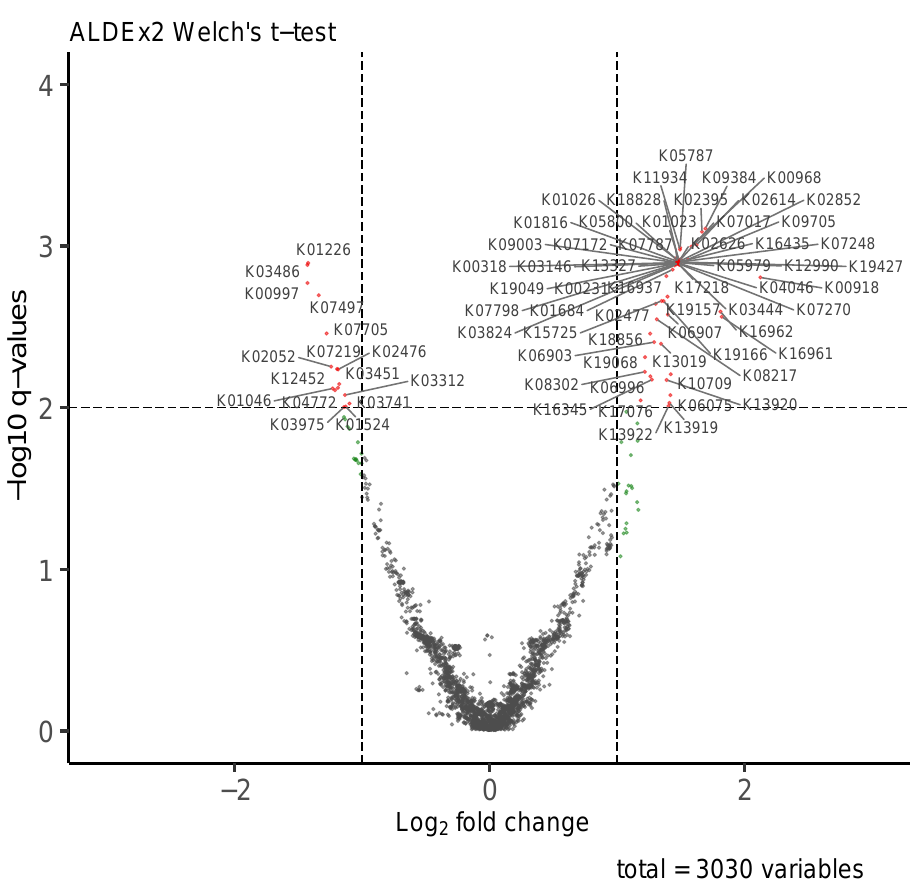
Figure 5. Volcano plot illustrating differentially involved KEGG terms based on the differentially abundant bacterial taxa between HFD-fed B6-mt ALR and B6-mt BPL mice. Each ID denotes respective KEGG ID. Pathways with the absolute log 2 fold change greater than 1 are considered to have suffi- ciently large positive and negative effect, respectively, and those with an adjusted p-values of minus log 10 q -value greater than 2 ( q < 0.01) are regarded as significant. BPL = B6-mt BPL , ALR = B6-mt ALR